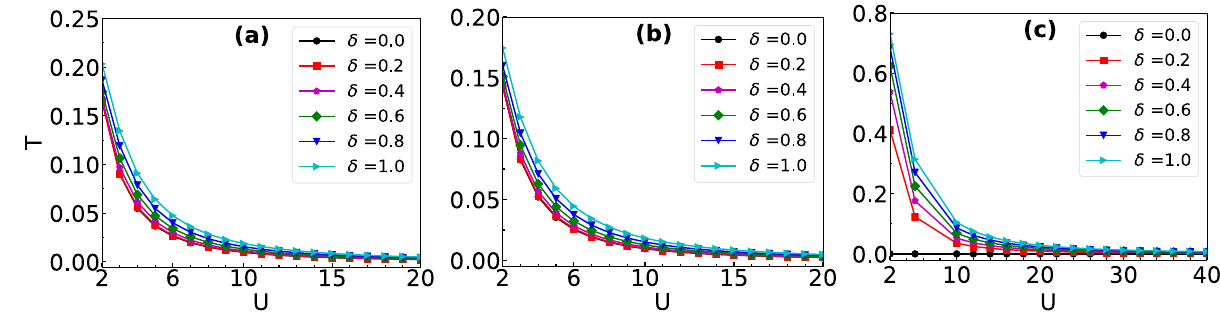
Figure 13. The transmission coefficient T is plotted with respect to U for different values of δ by evolving the initial state | �( 0 ) � to (a) t = 7 J − 1 , (b) t = 7 J − 1 and t = 23 J − 1 . ( a – c ) Correspond to the results obtained using the initial states given in Eqs. (11), (12) and (13) respectively.